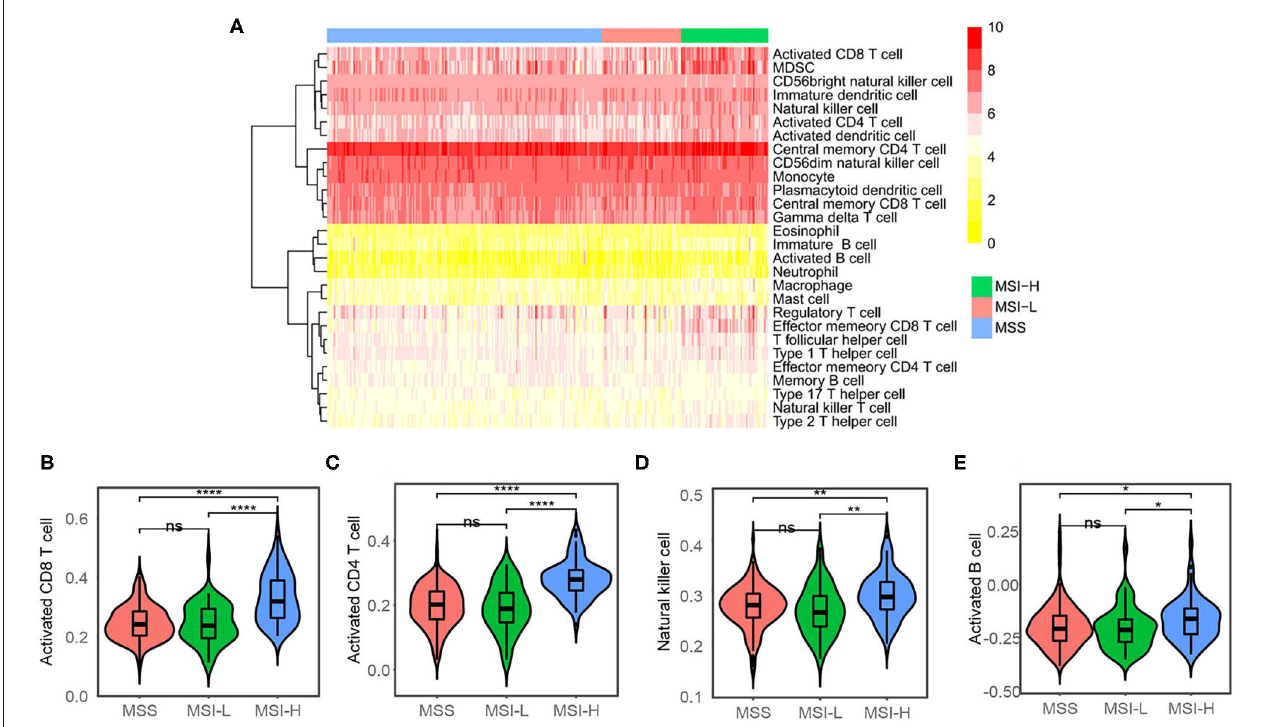
FIGURE 3 | Single sample gene set enrichment analysis (ssGSEA) analysis. (A) Heatmap showing the proportions of 28 types of immune cell. The proportions have been normalized to 0–10 across the 318 samples. (B) Activated CD8 + , (C) activated CD4 + , (D) natural killer cell, and (E) activated B cell were evaluated in the MSI-H samples compared with the MSS/MSI-L samples. ns: P > 0.05; * P < 0.05; ** P < 0.01; *** P < 0.001; **** P <